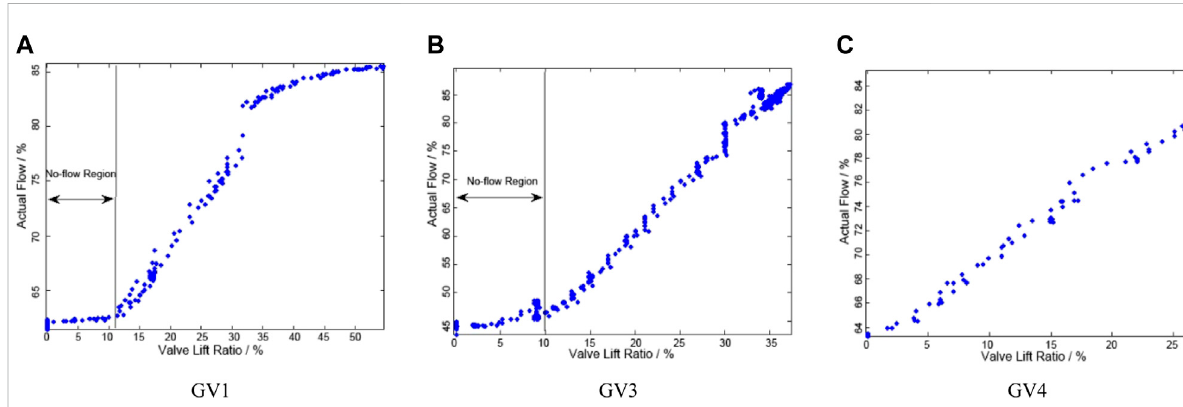
FIGURE 18 Relationships between the actual fl ow and valve lifts of GV1, GV3, and GV4. (A) GV1. (B) GV3. (C)